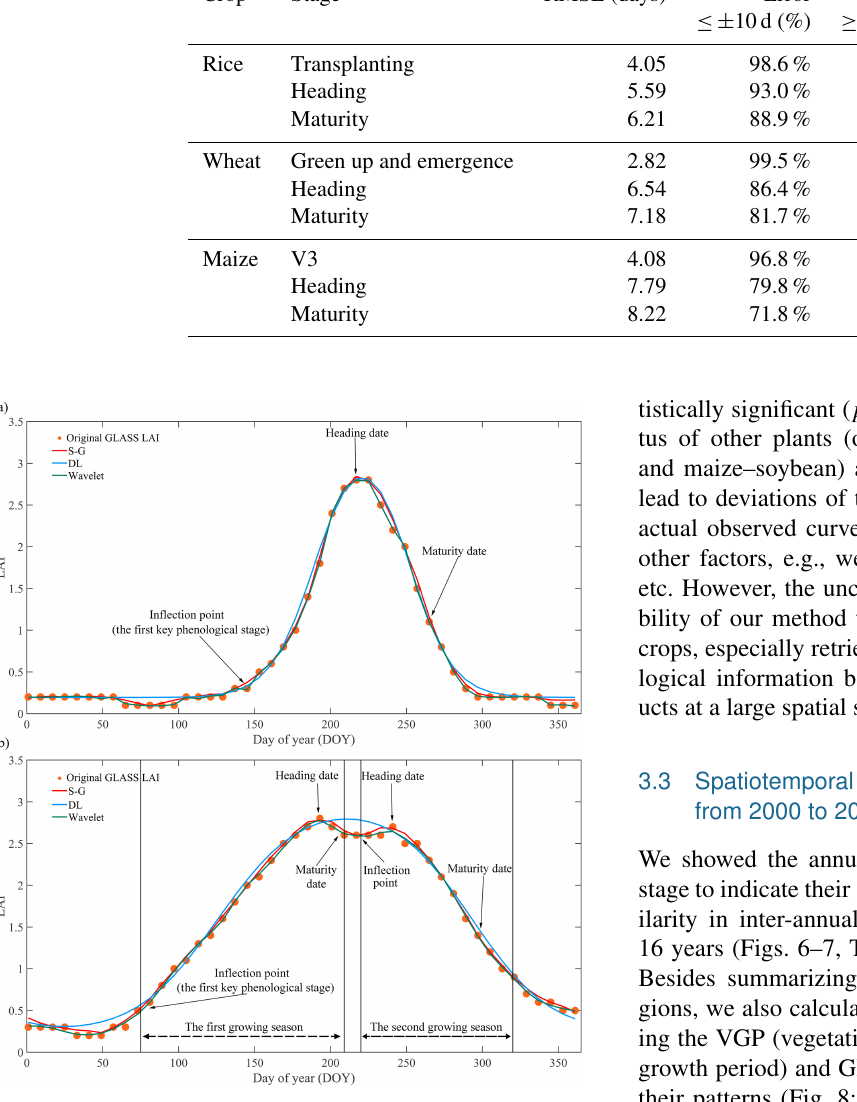
Figure 4. Comparisons of different smoothing methods for differ- ent cropping